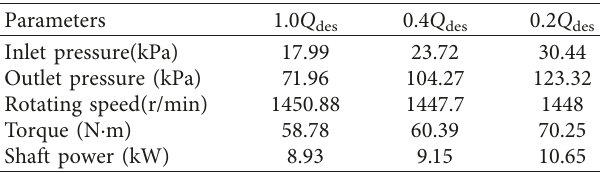
Figure 6: Measurement of axis orbit. (a) Position of eddy current displacement sensor. (b) Position of keyphasor. Table 2: Results of energy